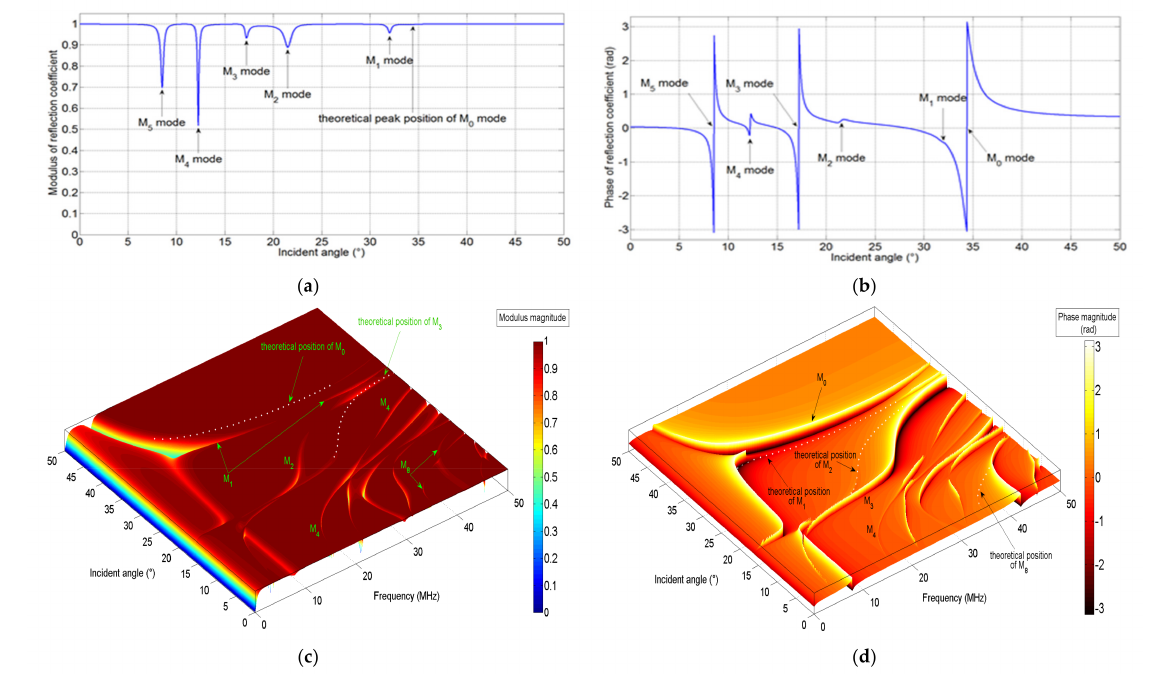
Figure 6. ( a ) Modulus of the reflection coefficient on the three-layer structure at 25 MHz; ( b ) corre- sponding phase of the reflection coefficient; ( c , d ) corresponding 3D global views of the modulus and phase of the reflection coefficient,